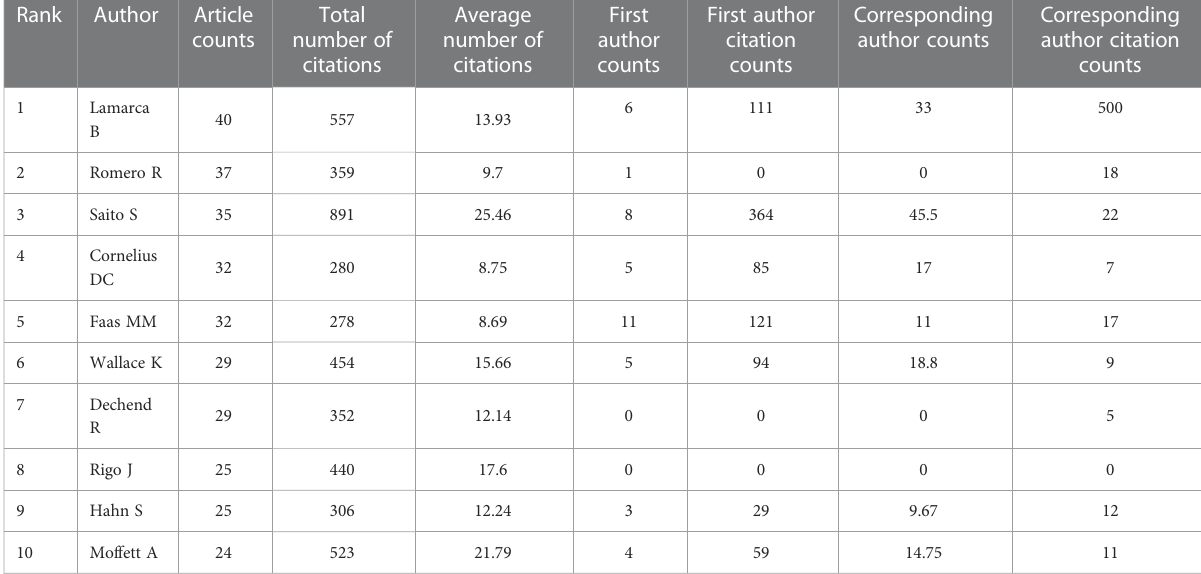
TABLE 2 The top 10 most productive authors in HDP and immune cells